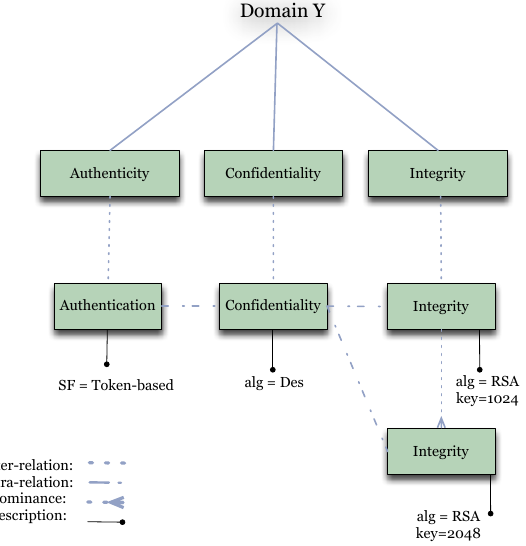
Figure 3. An example of a hierarchy of security properties for Domain